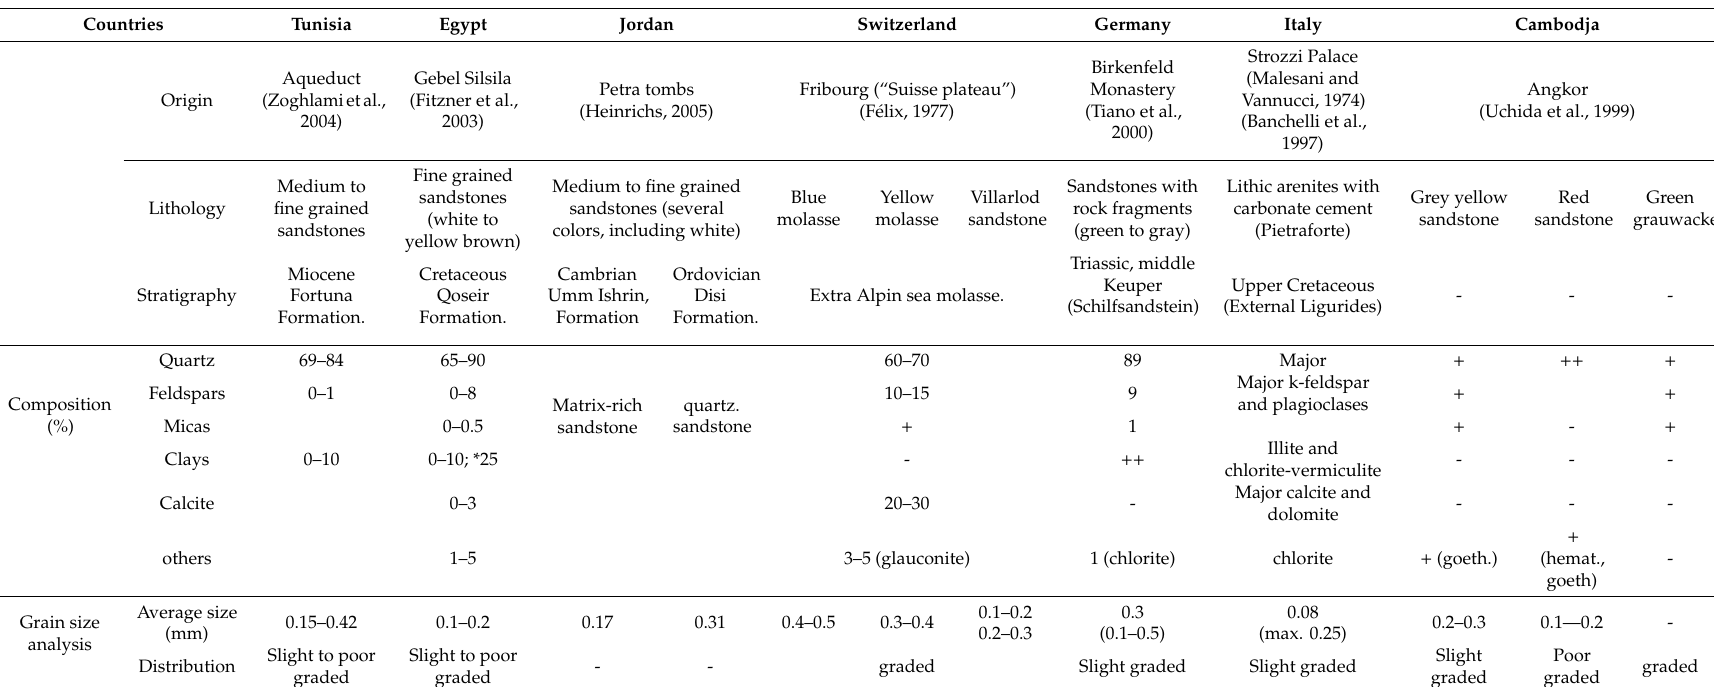
Table 1. Mineralogical characterization of building sandstones of world cultural